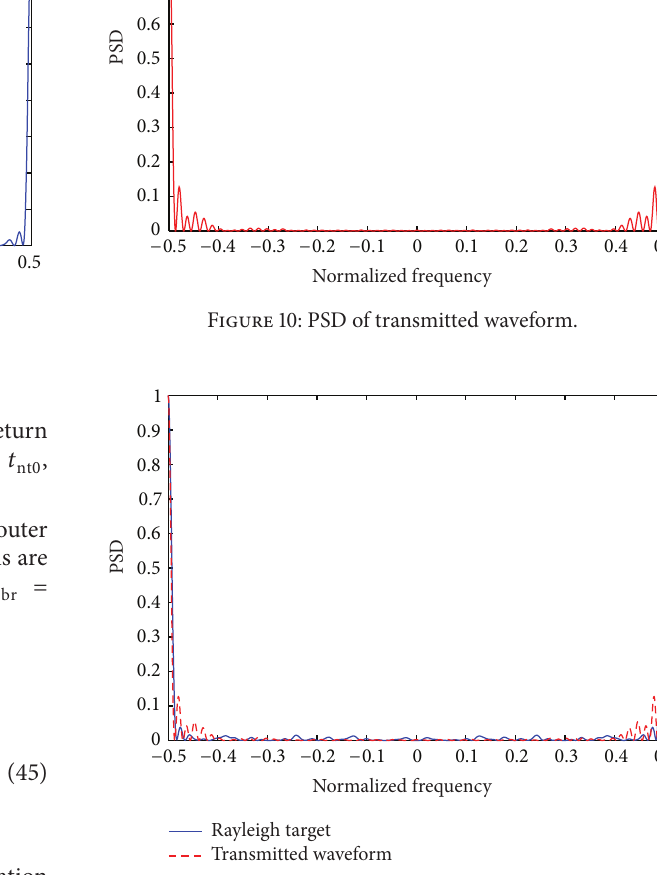
Figure 11: Superposition of PSD of Rayleigh target impulse and transmitted waveform (no